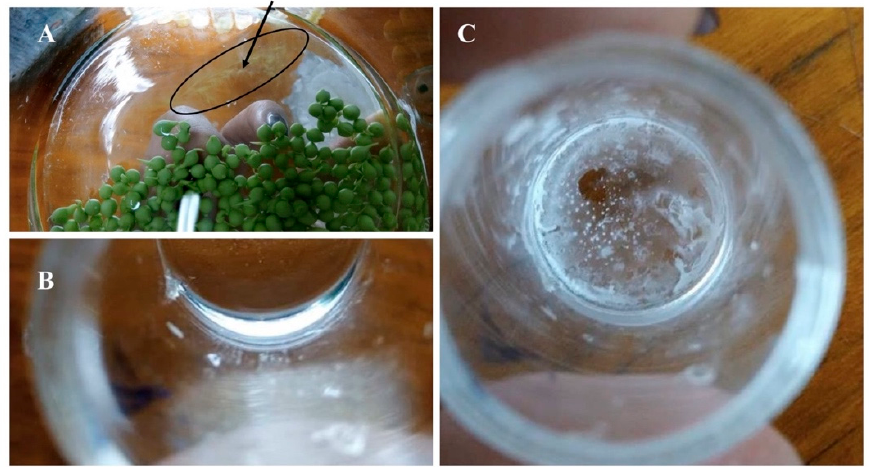
Figure 7. Evaluation of the integrity of the Poly(vinyl alcohol) (PVA) beads. ( A ) Leakage of cells from the beads, after 7 days of being prepared. ( B ) Filtrated solution (f/2 medium and addition of pharmaceuticals) of the control group, after the removal of the beads of PVA without cells. ( C ) Evaporation of the water, a film of PVA settled at the bottom of the glass beaker.